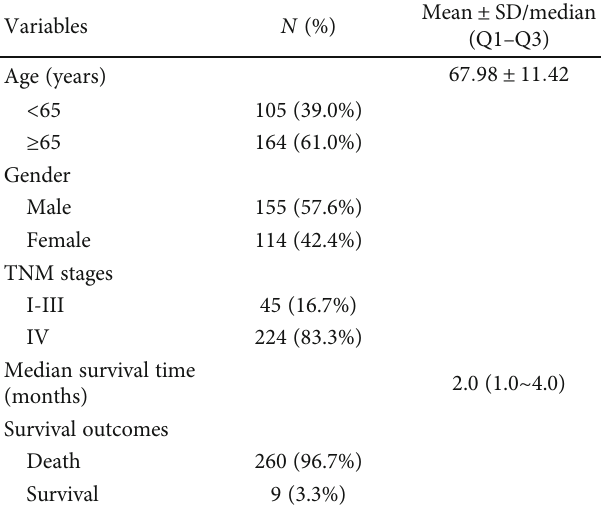
Table 1: Clinicopathologic